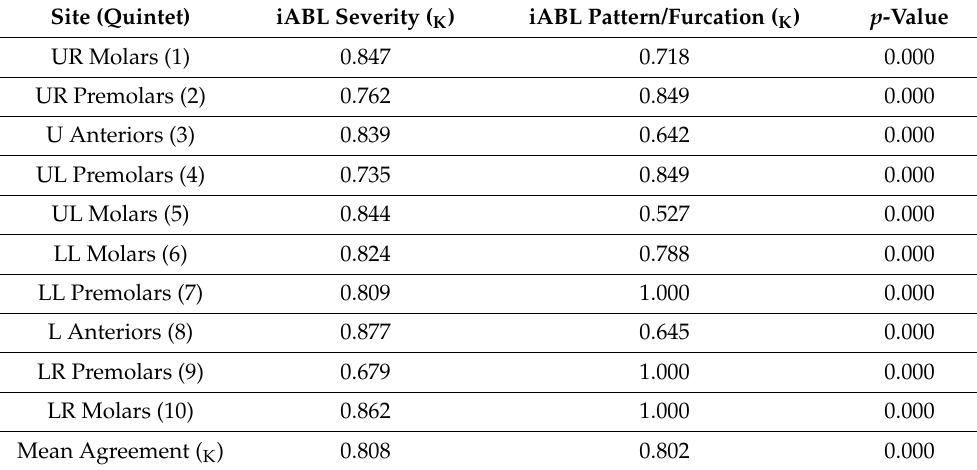
Table 3. Intra-examiner agreement scores